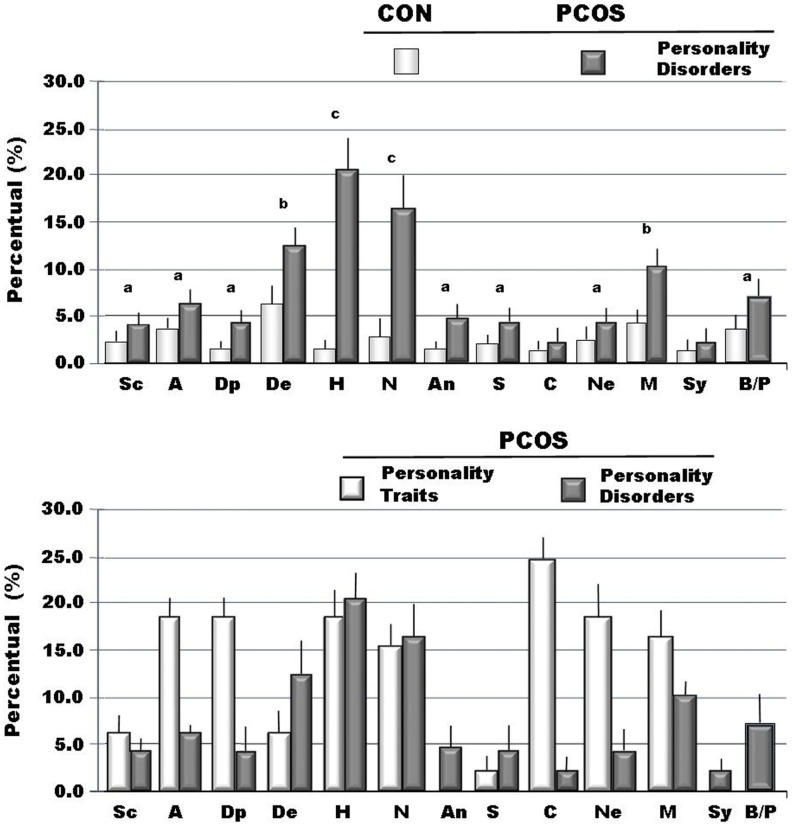
The incidence of traits and of personality disorders (DSM-IV axis II) recorded through MCMI-III in personality scales (BR ≥ 75 is personality trait; BR ≥ 85 is disorder) (22). Legend: Sc, schizoid; A, avoidant; Dp, depressive; De, dependent; H, histrionic; N, narcissistic; An, antisocial; S, sadistic; C, compulsive; Ne, negativistic; M, masochistic; Sy, schizotypal; B, borderline; P, paranoid; ap < 0.05 vs. Cont; bp < 0.01vs. Cont; cp < 0.005 vs. Cont.